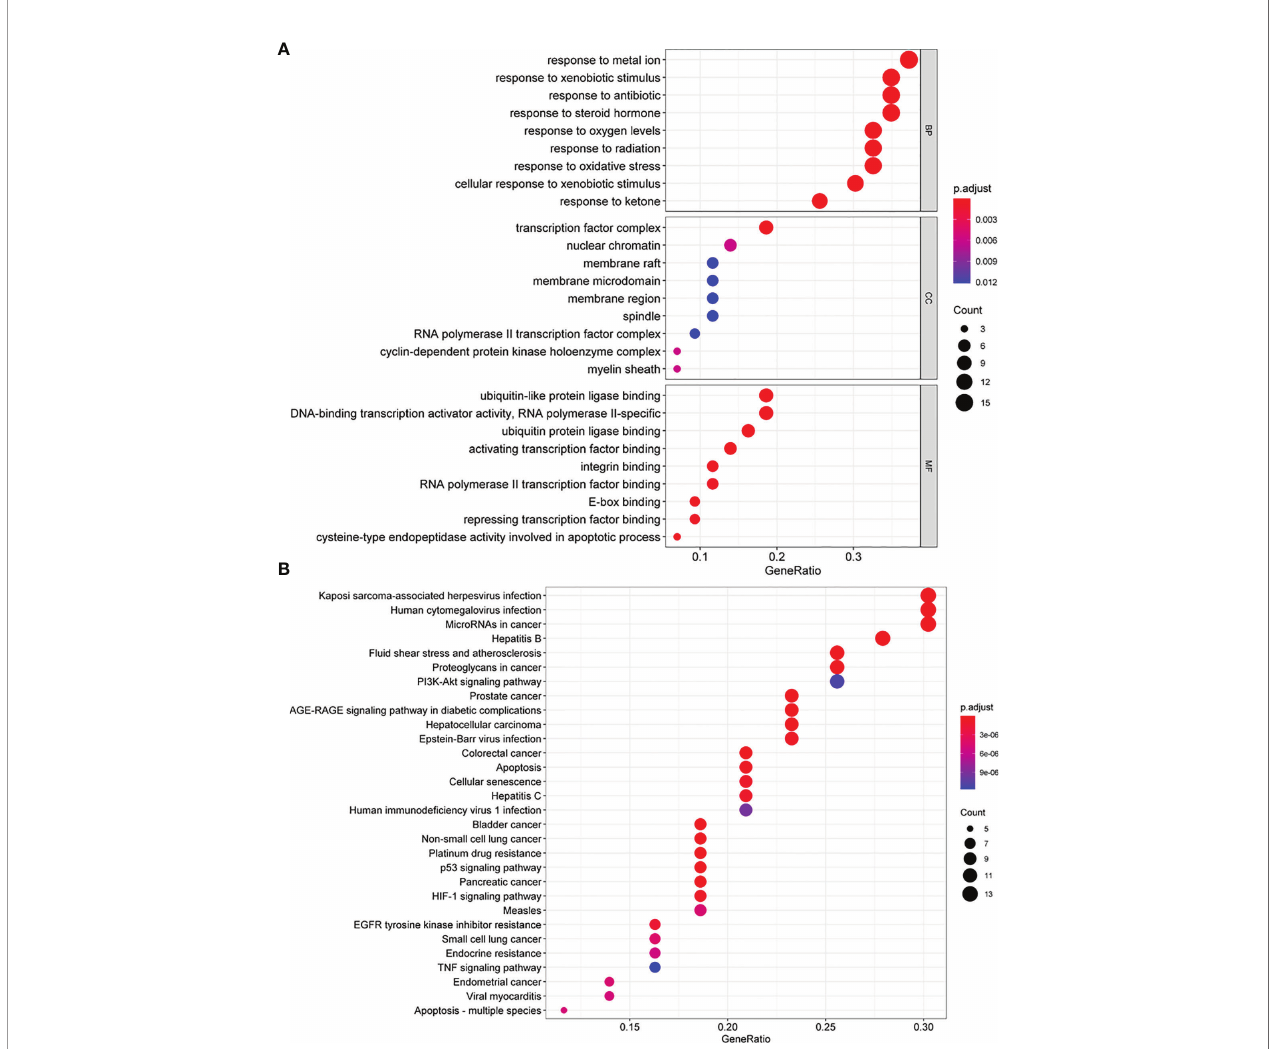
FIGURE 6 | GO and KEGG enrichment analysis of quercetin synergism with cisplatin anti-cervical cancer genes. (A) The GO enrichment analysis of quercetin synergizing with cisplatin anti-cervical cancer genes. Ontology covers three domains: biological process (BP), cellular component (CC), and molecular function (MF). The abscissa GeneRatio represents the proportion of genes of interest in the entry, and the ordinate represents each entry. The size of the dots represents the number of genes annotated in the entry, and the color of the dots represents the corrected P -value of the hypergeometric test. (B) The KEGG enrichment analysis of quercetin synergizing with cisplatin to target anti-cervical cancer genes. The abscissa represents the number of genes annotated in the pathway, the ordinate represents the pathway, and the color of the column represents the corrected P -value. KEGG, Kyoto Encyclopedia of Genes and Genomes; GO, Gene